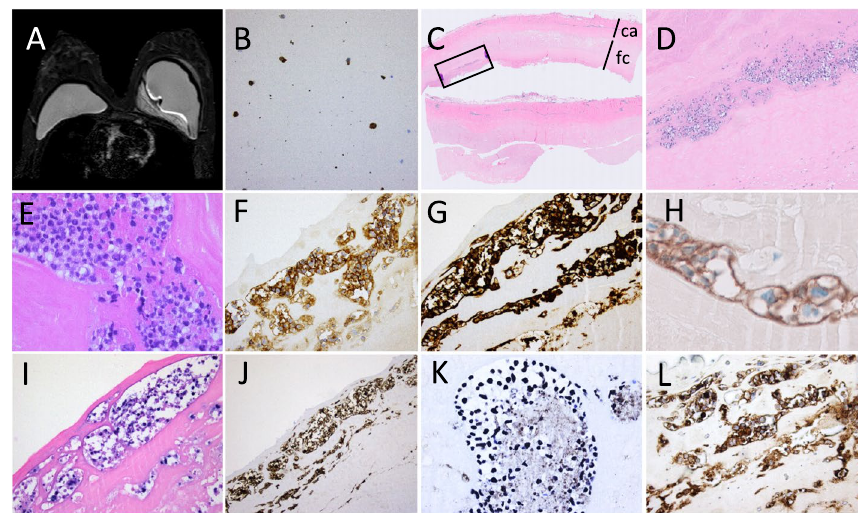
Fig. 2 Case 2. A . MRI shows intact breast implants, and a thick-walled fluid collection with intralesional septations, but no contrast capturing, medially of the implant in the left breast; B . FNAC cytology shows large atypical cells (Papanicolaou stain), expressing CD30 and PAX5 (not shown); C . HE stain of the left capsulectomy specimen, showing a fibrous capsule (ca) with a fibrinous cover (fc), containing clusters of large atypical lymphoid cells (square in D, enlarged in D - E ), expressing CD30 ( F ), and B-cell markers CD20 ( G ), OCT2, PAX5 and BOB1, and also the hypoxia marker CA-9 ( H ); Presence of EBV was shown by EBER ISH ( I ), displaying an EBV latency type III, with expression of LMP1 ( J ) and EBNA2 ( K ); There was no T-cell marker expression, but the cells were positive for PD-L1 ( L